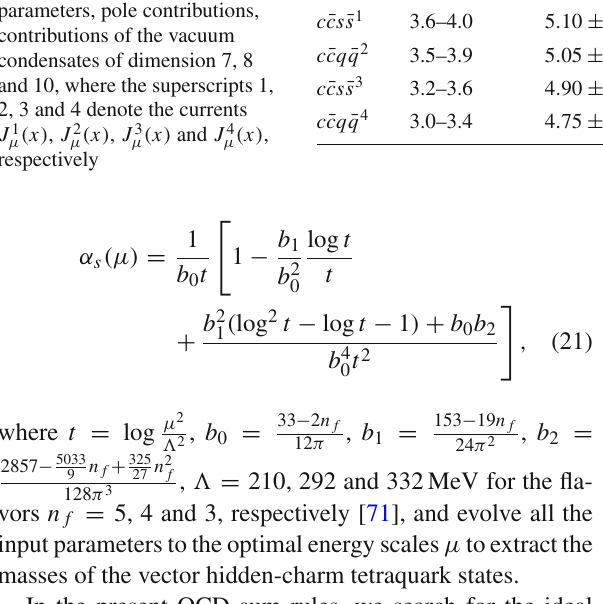
Table 2 The Borel parameters, continuum threshold parameters, pole contributions, contributions of the vacuum condensates of dimension 7,